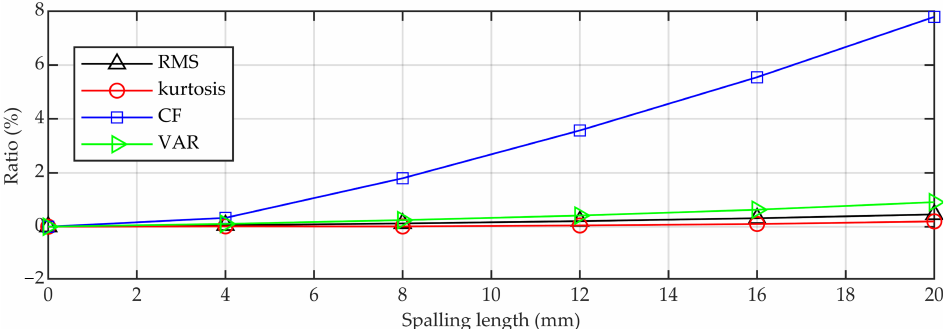
Figure 8. The variations of the RMS, kurtosis, CF, and VAR of the first gearbox housing vertical vibration at different spalling lengths.